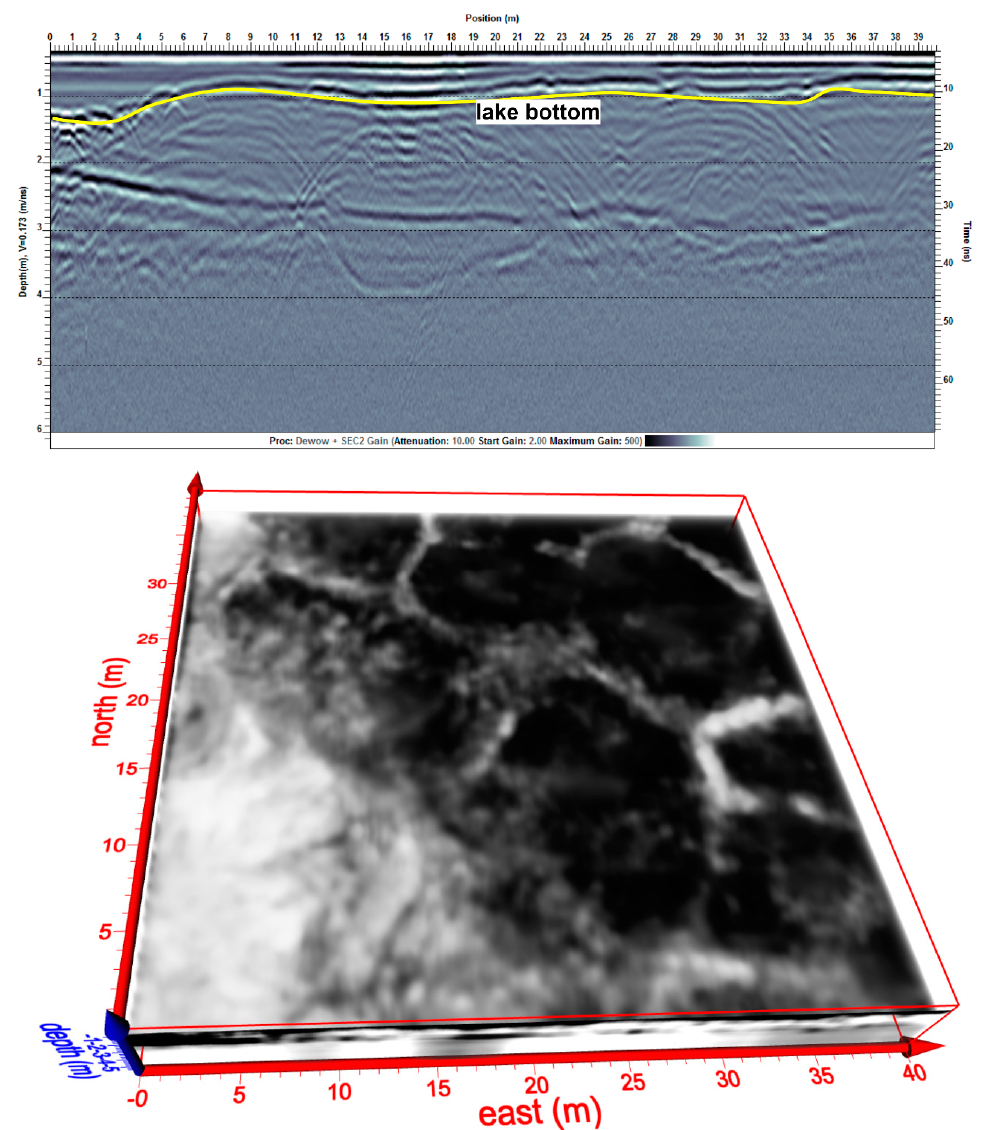
Figure 16. Just beneath the shallow lake bottom, the GPR data reveal patterns characteristic of ice wedge polygons. The interface of the silty lake bottom, upon which the mammoth bones rest is indicated in the profile ( top ). A deeper interface seen in the profiles may be due to a textural transition in the substrate, from finer-grain sediment to coarse gravel.